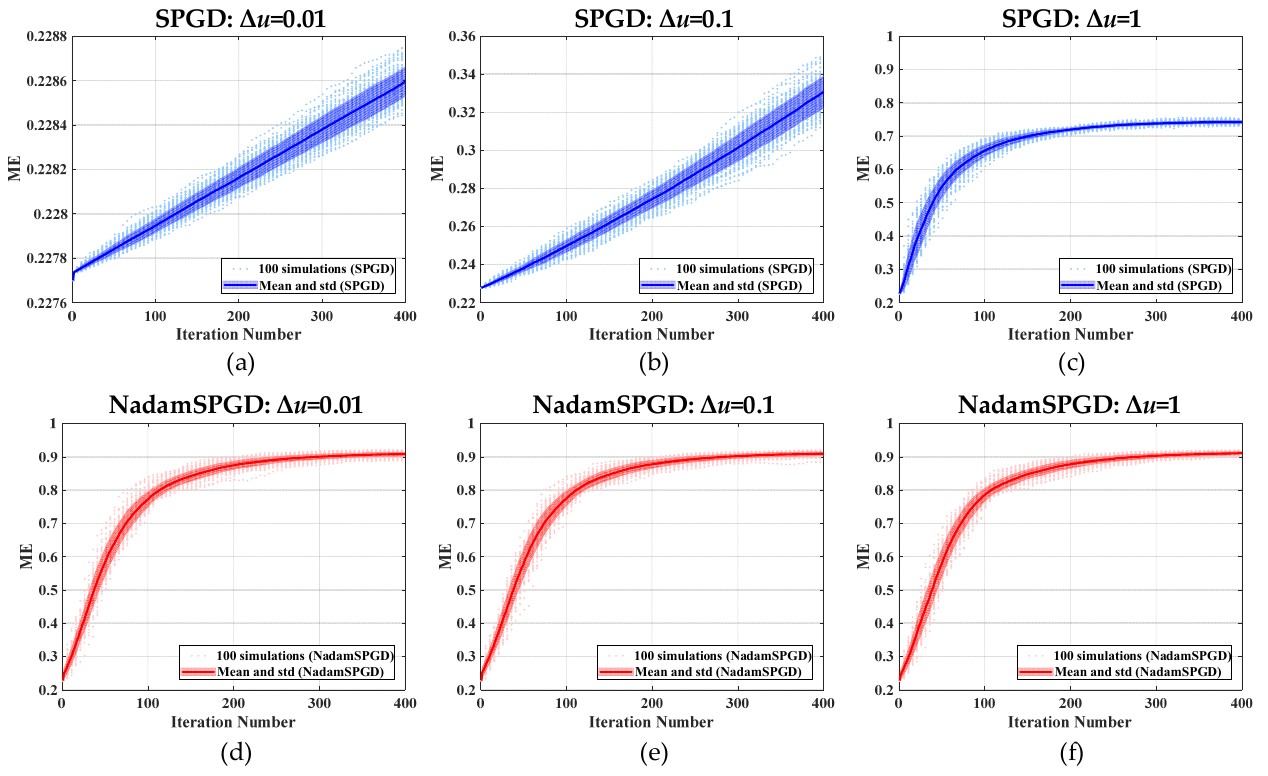
Figure 6. Comparison of SPGD and NadamSPGD under different ∆ u values: ( a ) SPGD curve when ∆ u = 0.01; ( b ) SPGD curve when ∆ u = 0.1; ( c ) SPGD curve when ∆ u = 1; ( d ) NadamSPGD curve when ∆ u = 0.01; ( e ) NadamSPGD curve when ∆ u = 0.1; ( f ) NadamSPGD curve when ∆ u = 1.